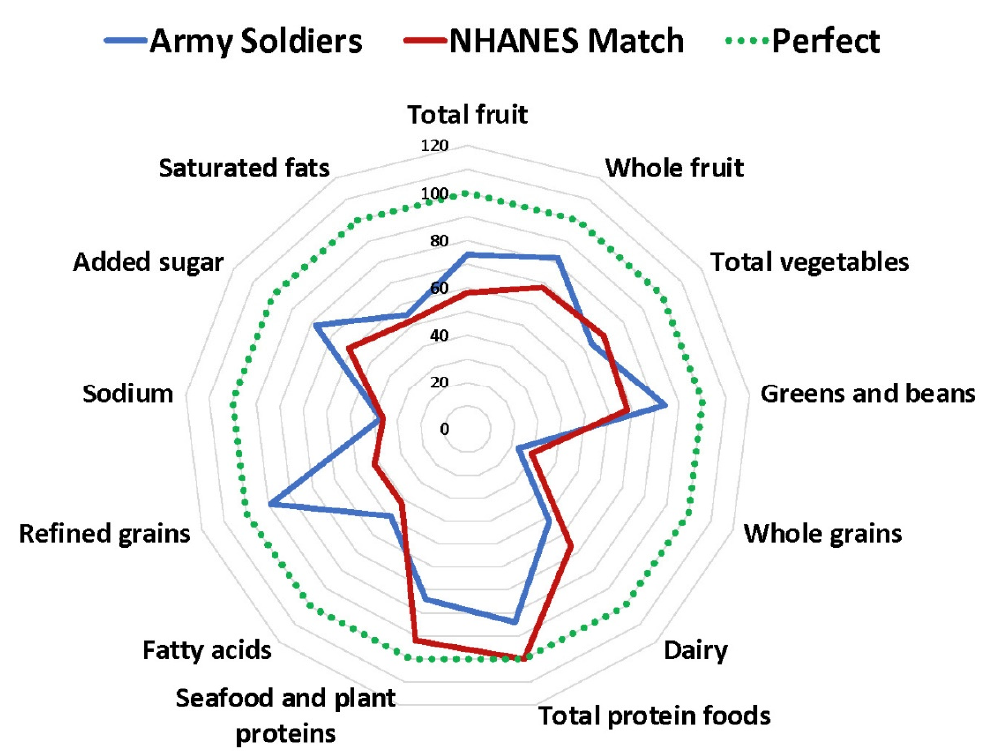
Figure 1. Soldiers’ HEI component scores compared to the NHANES matched group, according to the Healthy Eating Index-2015.